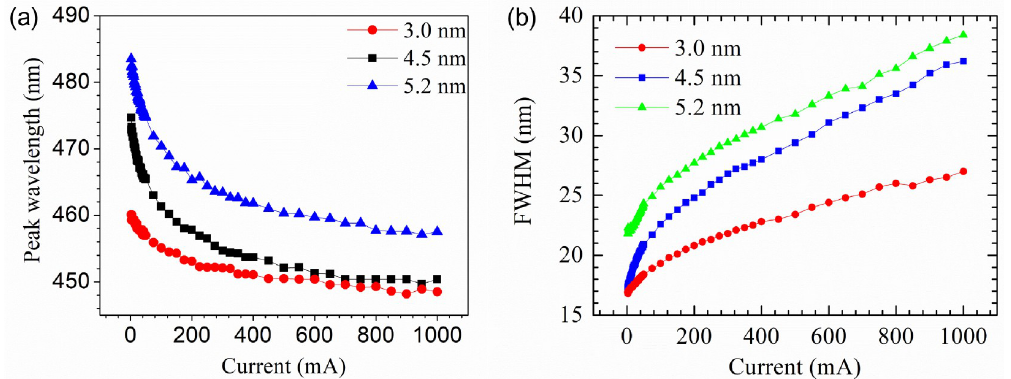
Figure 2. ( a ) The electroluminescent (EL) emission peak and ( b ) full-width half maximum (FWHM) versus injection current for the LEDs with di ff erent last quantum wells (LQWs) of 3.0 nm, 4.5 nm and 5.2 nm.